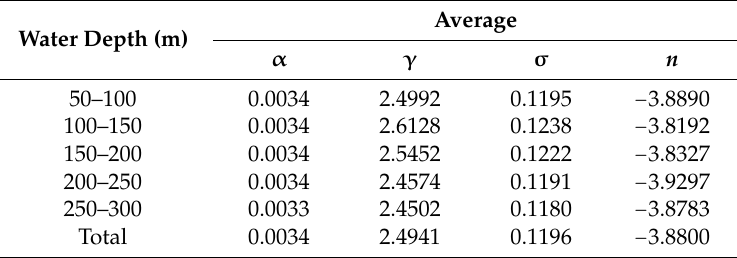
Table 12. JONSWAP parameters under non-typhoon conditions for different water